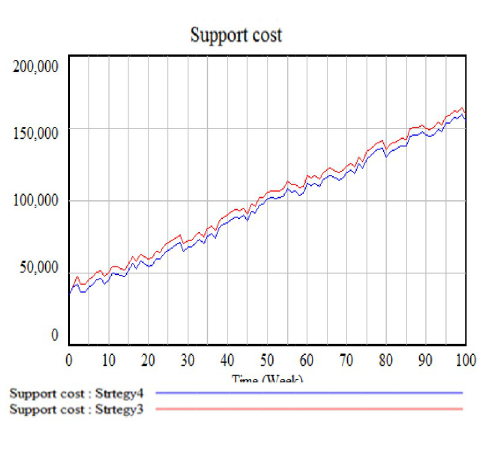
Figure 15. Warship spare parts all-in support cost